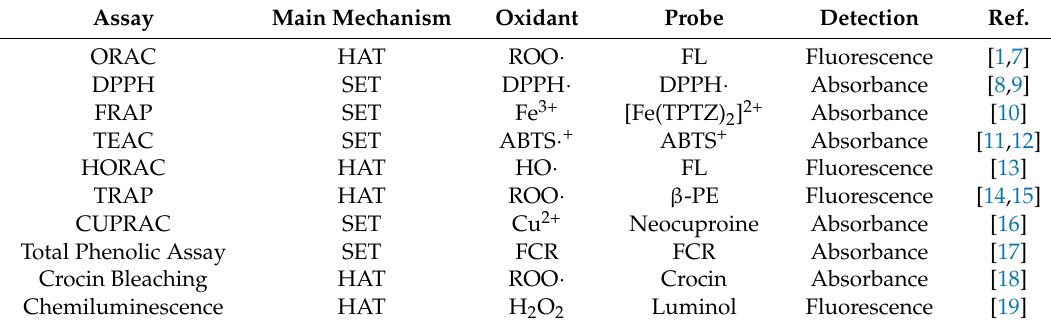
Table 1. List of the widespread assays to evaluate Antioxidant